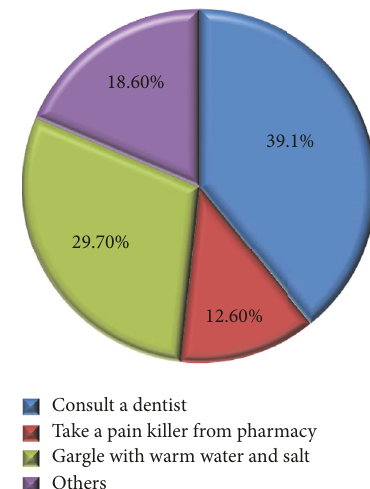
Figure 5: Measures taken during pain by the study